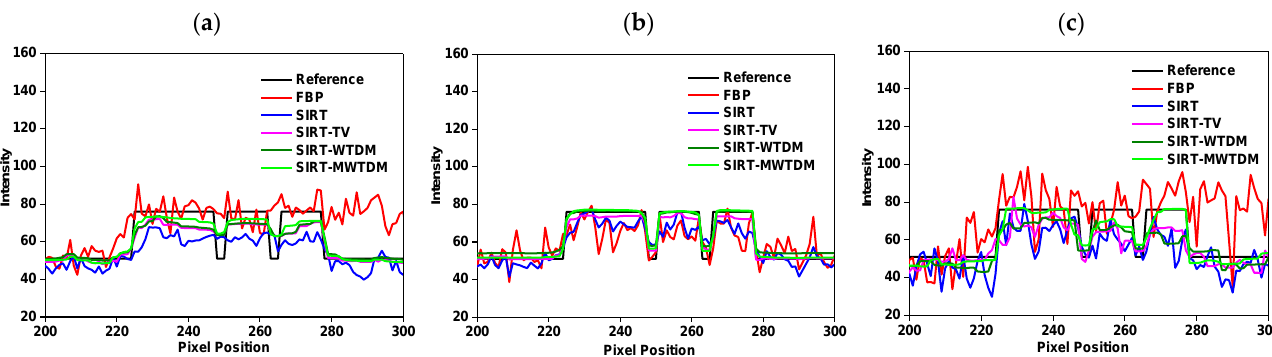
. As for the SIRT-TV algorithm,